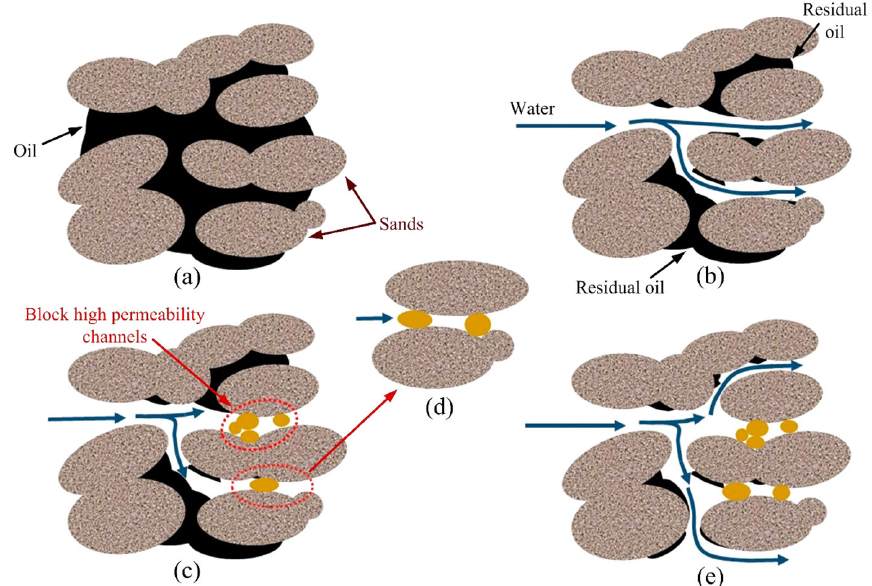
Figure 18. Profile control mechanism and microstructure of DPG. ( a ) Initial distribution of crude oil in the reservoir; ( b ) water breakthrough along the high permeability channels after long-term water flooding; ( c ) plugging the high permeability channels by DPG; ( d ) deformed DPG particles pass through the pore throat; ( e ) increased sweep efficiency after the DPG treatment. (Reprinted/adapted with permission from Ref. [40], 2016, Liu et al.).